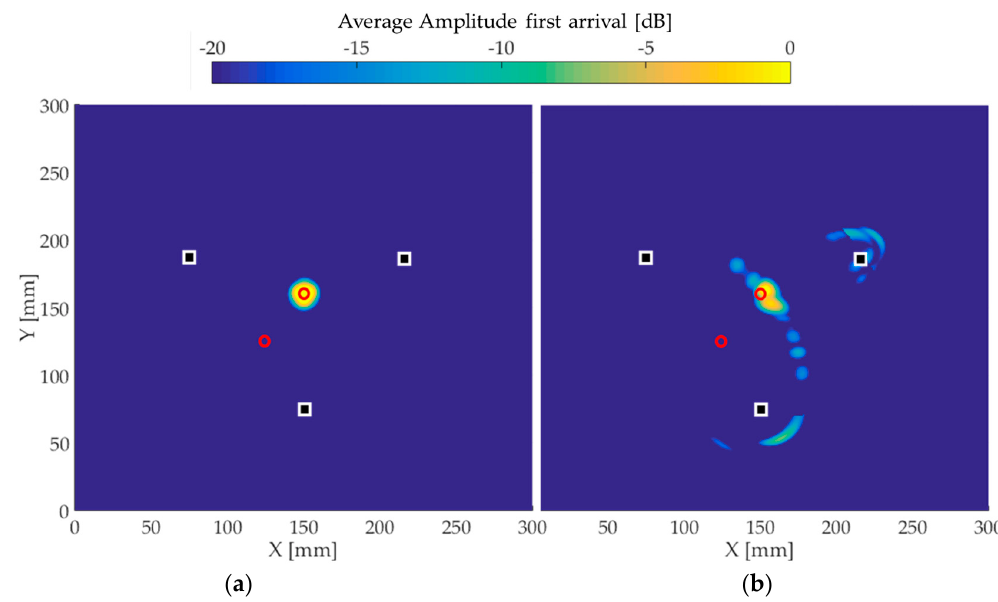
Figure 10. Reconstructed images for the second 5 mm through-thickness hole. The white squares represent the transducers positions and the red circles correspond to the defect position. ( a ) The image using simulated time traces and ( b ) the experimental image.